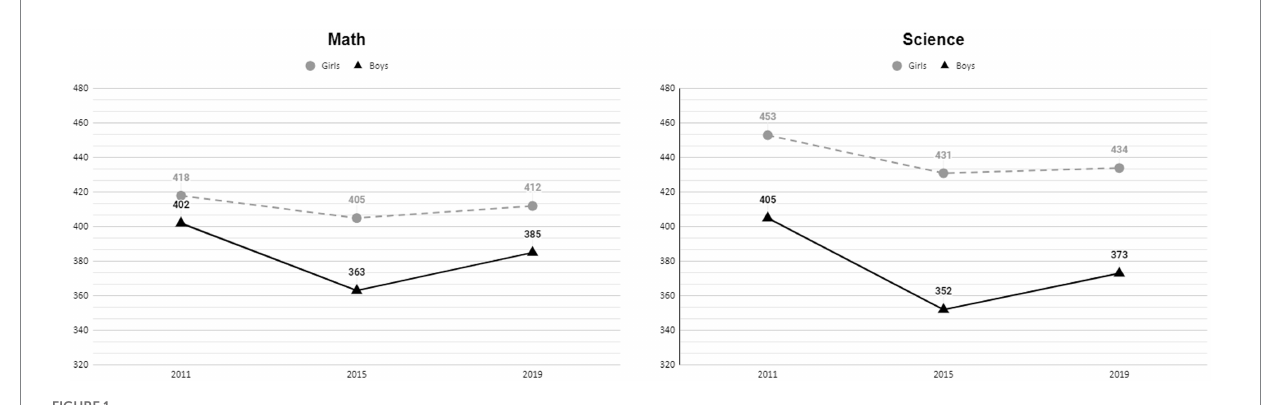
FIGURE 1 Average mathematics and science achievement across years by